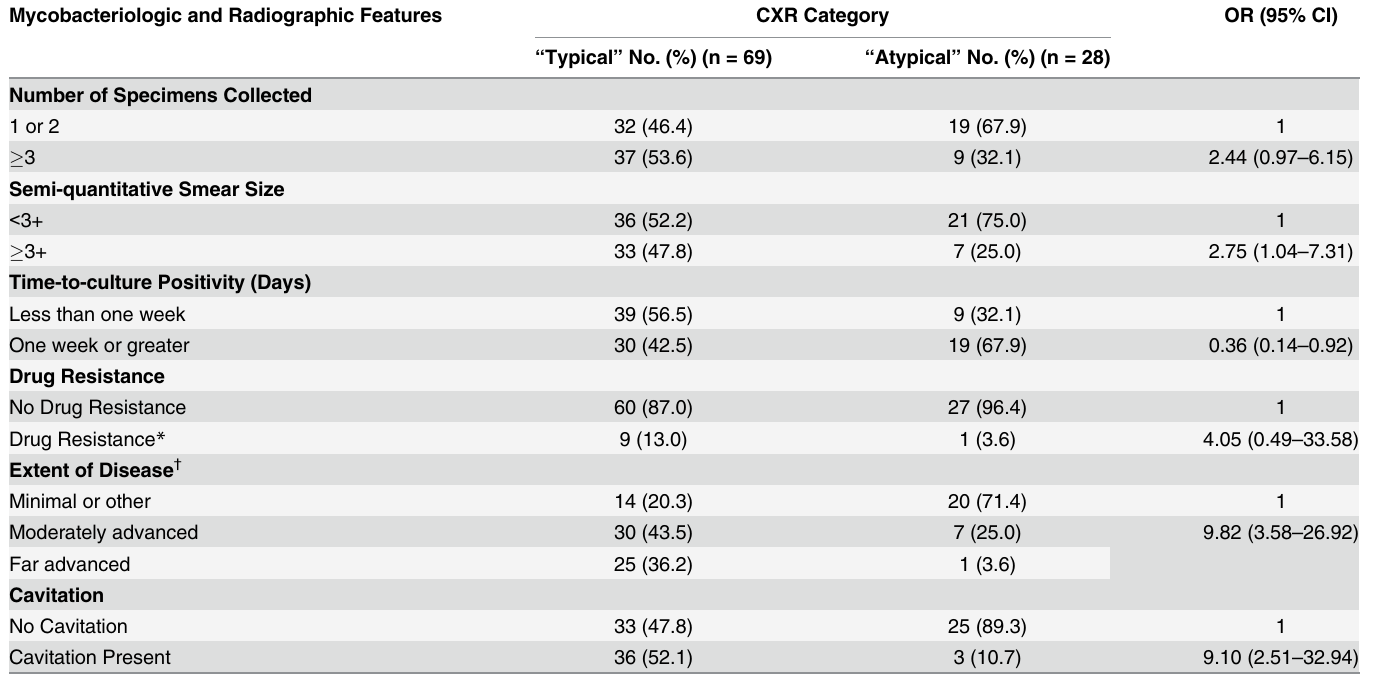
Table 3. Bacillary burden and cavitation in smear-positive pulmonary TB cases with “ typical ” and “ atypical ” chest radiographic features. Mycobacteriologic and Radiographic Features